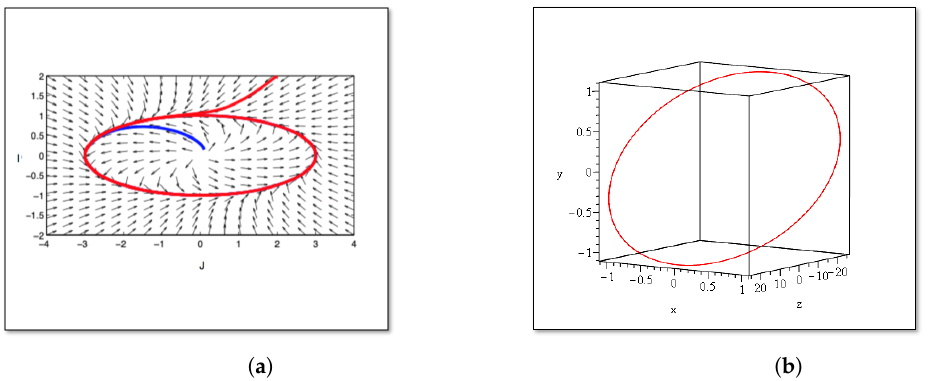
Figure 2. Example of a periodic orbit in a cube. ( a ) Elliptical Limit Set in Oblique Coordinates. ( b ) Elliptical Limit Set in Lattice Cubical